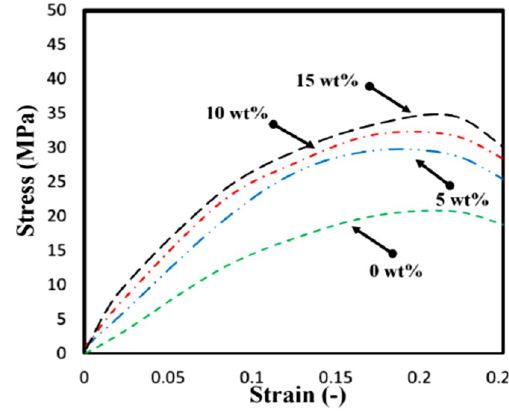
Fig. 23 Stress–strain plot of BS [125]